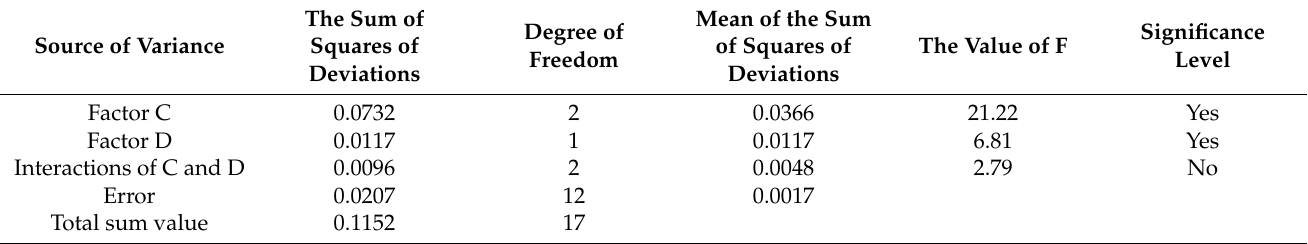
Table 14. Analysis of variance for orthogonal tests of different water quality and